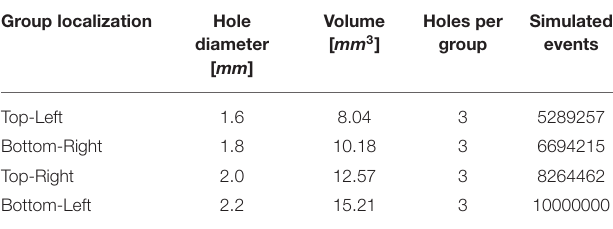
TABLE 2 | De Renzo phantom simulation